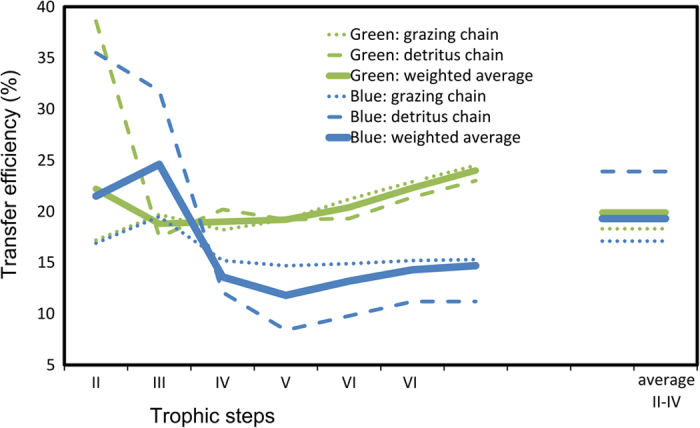
Transfer efficiencies for each trophic step (II = step from TL1 to TL 2).Weighted averages are conventionally reported for the first 4 TLs.